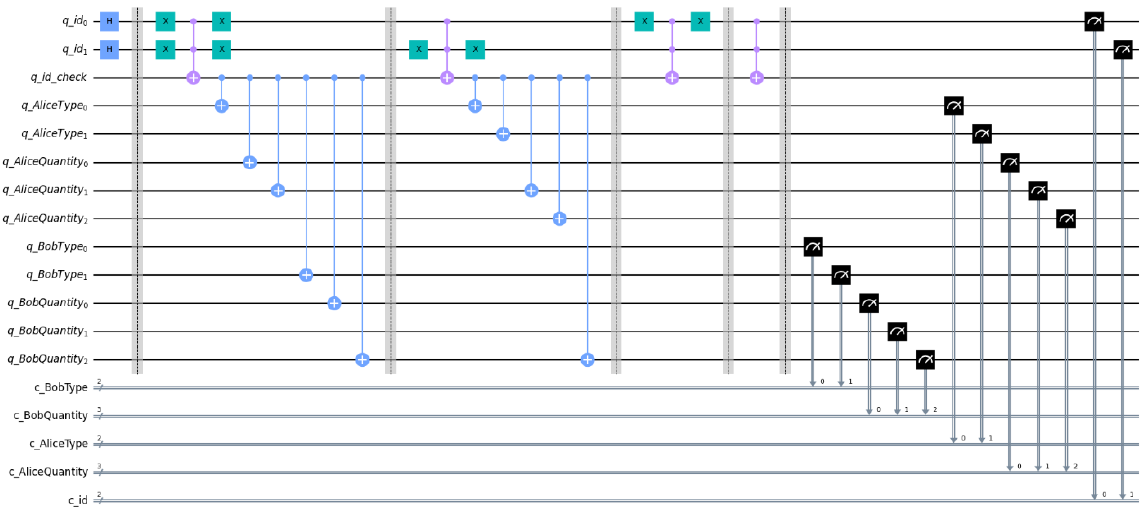
Figure 7. The alternative circuit for a series of transactions between Alice and Bob, using a local identifier.